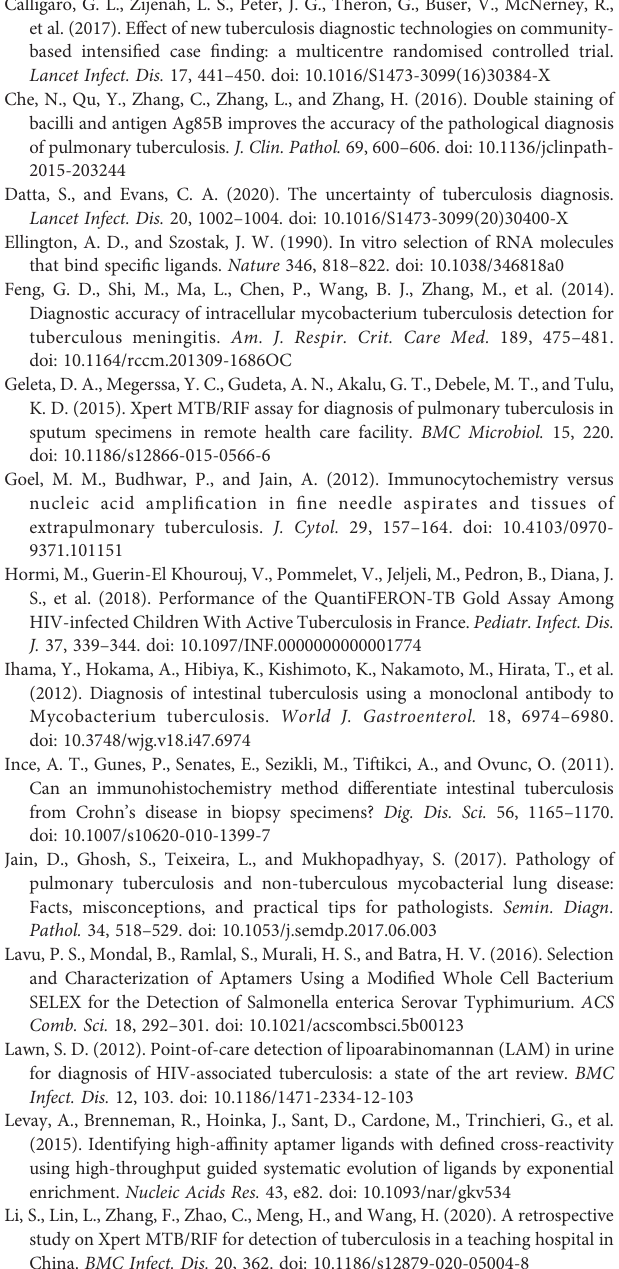
bronchiectasis, lung cancer); TB: Tuberculosis; AFS-/+: acid fast staining negative/positive; Culture-/+: culture negative/negative; IGRA -/+: IGRA positive/negative. Supplementary Figure 2 | Comparison of aptamer- and antibodies-based IHC for TB diagnosis with patient tissue lesions. Images of lesion sections of LNTB patient (A) and NTM patient (B) detected by aptamer-based IHC (upper panel), IHC with anti-Ag85B (middle panel), and IHC with anti-Rv2645 (lower